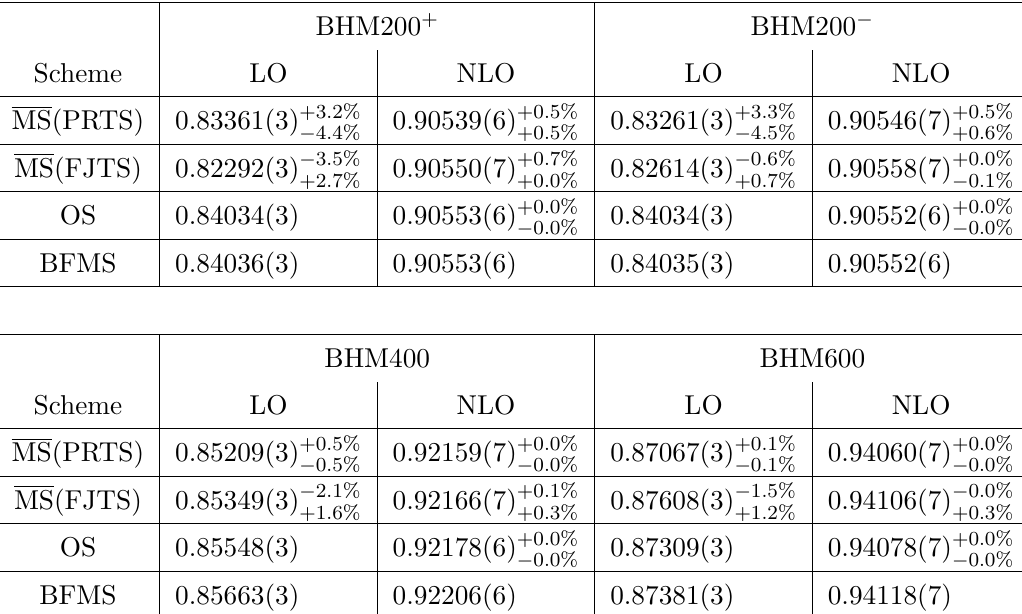
Table 4 . LO and NLO decay widths (cid:0) H 2 ! 4 f [MeV] of the light HSESM Higgs boson H 2 for various HSESM scenarios in di(cid:11)erent renormalization schemes, with the OS scheme as input scheme (and full conversion of the input parameters into the other schemes). The scale variation (given in percent) corresponds to the scales (cid:22) = (cid:22) 0 = 2 and (cid:22) = 2 (cid:22) 0 with central scale (cid:22) 0 = M H